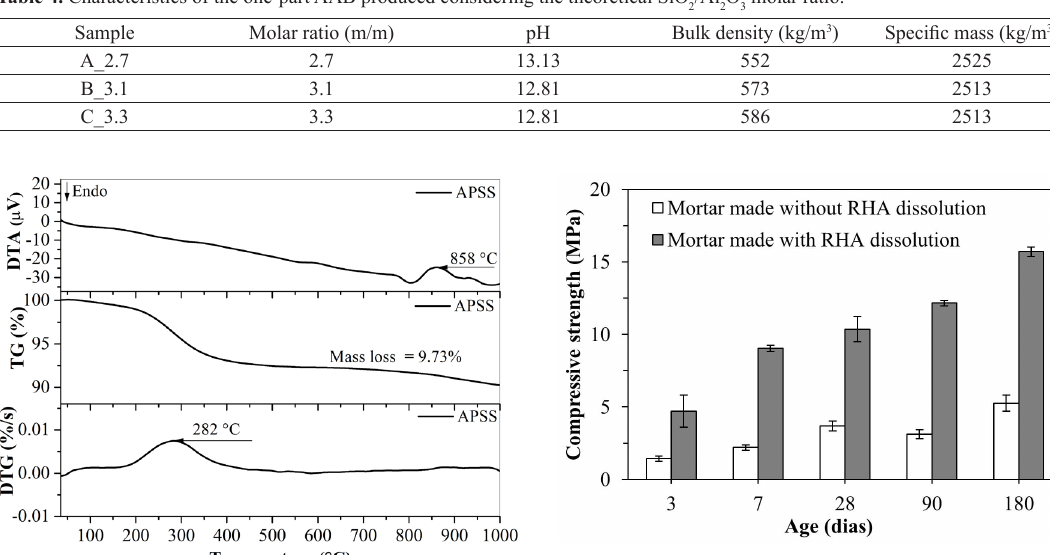
Figure 7. Influence of RHA dissolution step in the compressive strength of mortars made with one-part